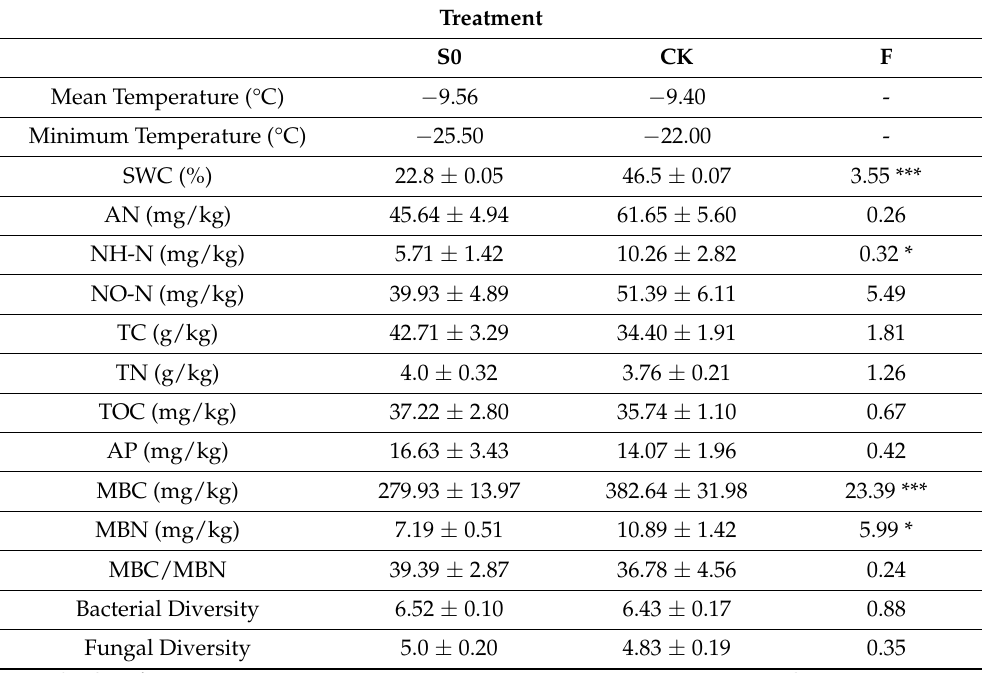
Table 1. Environmental variables (mean ± SE) of the upper soil layer (0–10 cm) in the snow removal (S0) and control (CK) plots during the spring snowmelt period (March